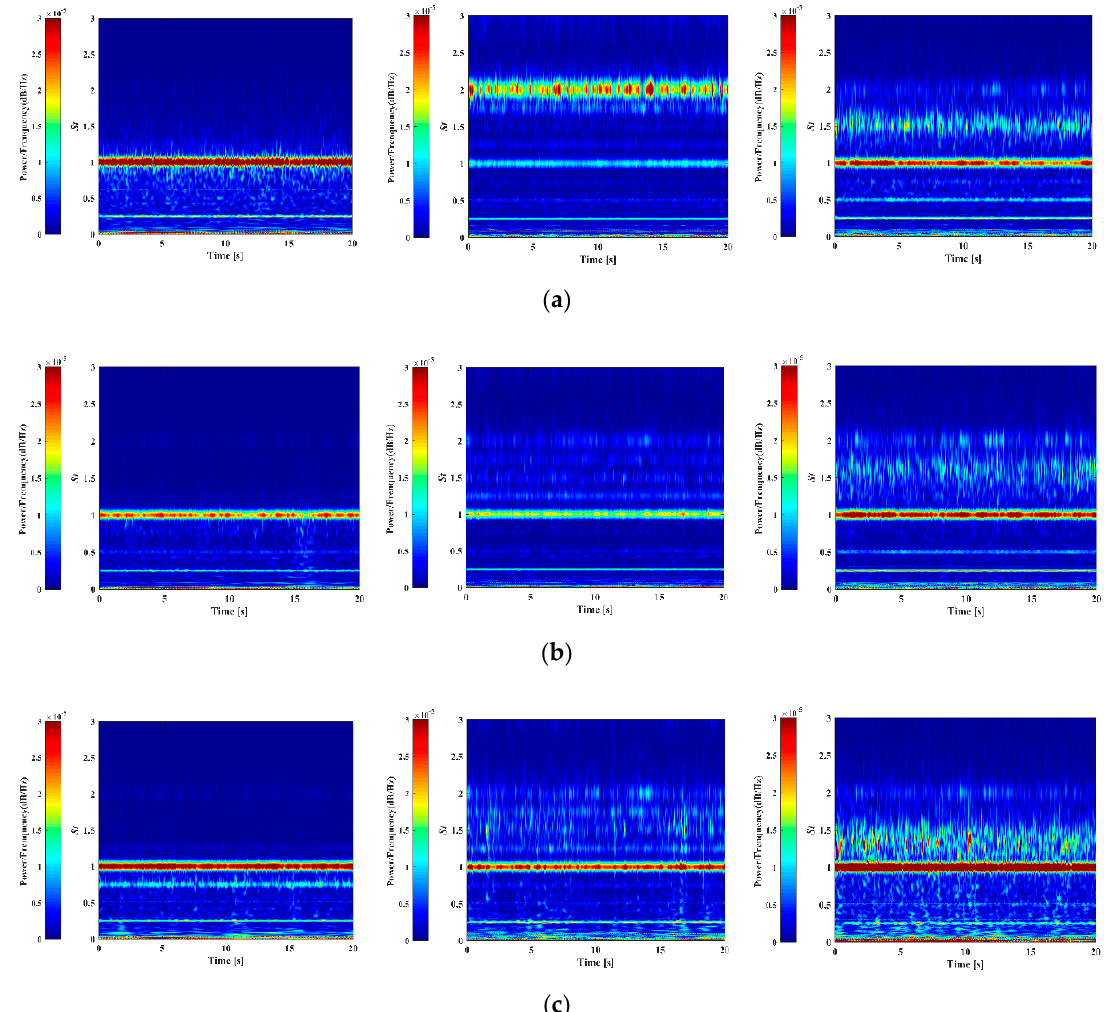
Figure 15. Time-frequency domain of pressure pulsations for three schemes at H max = 6.5 m: ( a ) P1; ( b ) P2; ( c ) P3 (Each row from left to right is H = 204 mm, 164 mm and 142 mm).